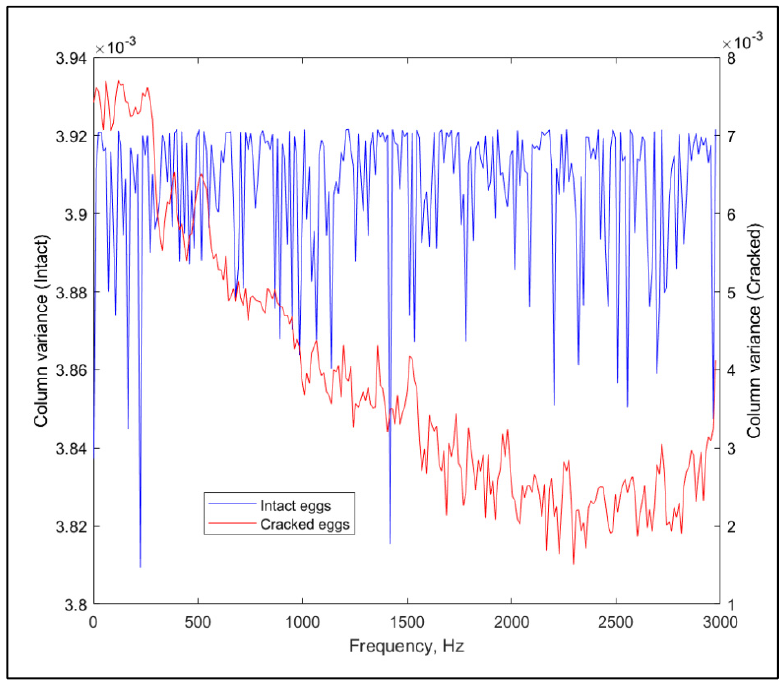
Figure 1. Column variances of the PCA coefficients for the two groups of samples.